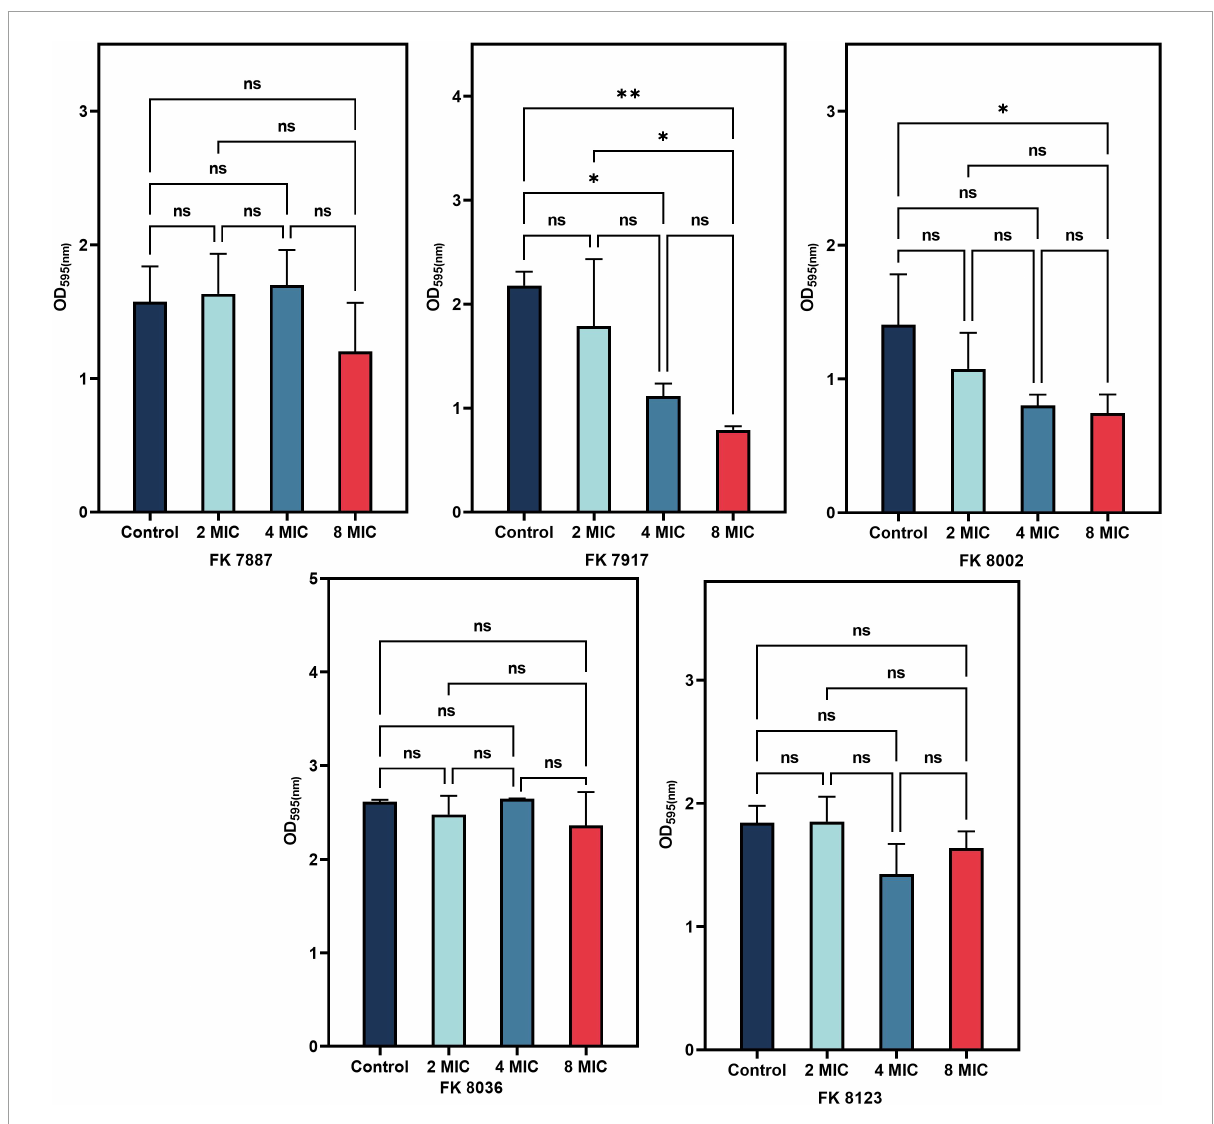
FIGURE8 Radiation effect of chlorogenic acid (CA) on five carbapenem-resistant Klebsiella pneumoniae (CRKP) mature biofilm at 1/2, 1/4, and 1/8 minimum inhibitory concentration (MIC). “ ∗ ” Means P < 0.05, “ ∗∗ ” means P < 0.01, and “ns” means P >